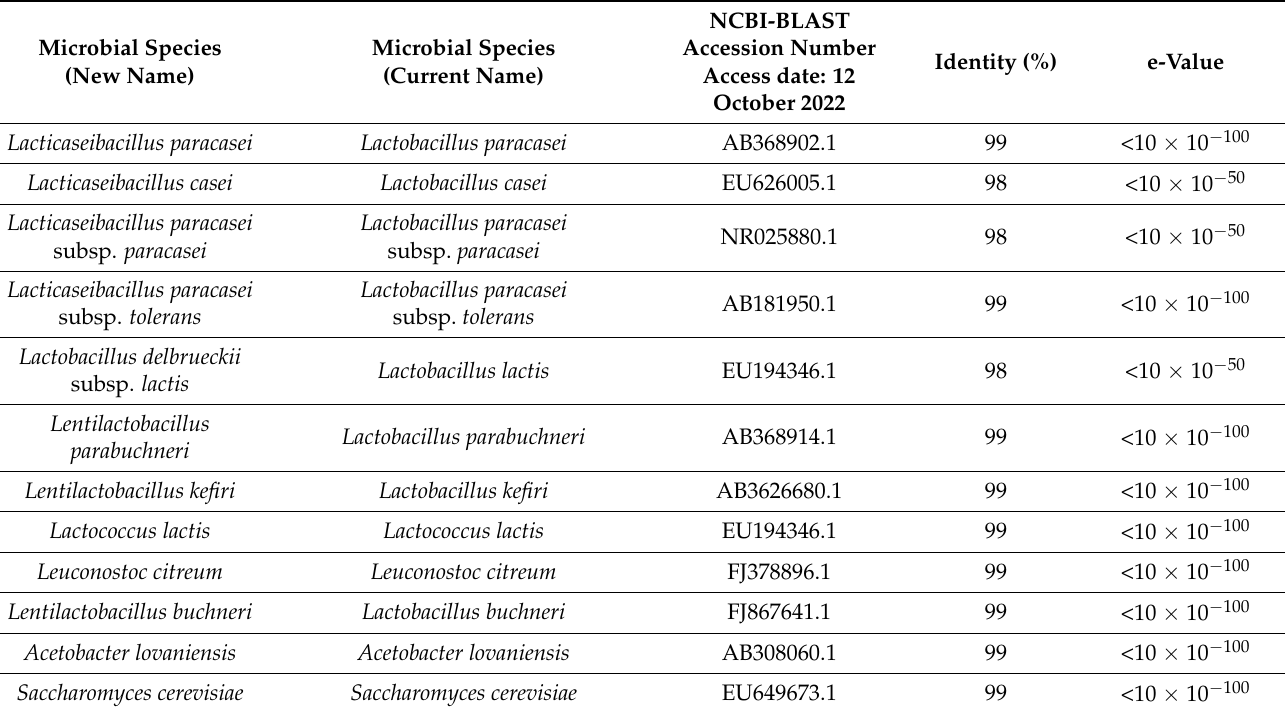
Table 2. Microorganisms present in water kefir grains and beverages (demerara, molasses, brown, refined, coconut) as identified by PCR-DGGE analysis and species sequencing.